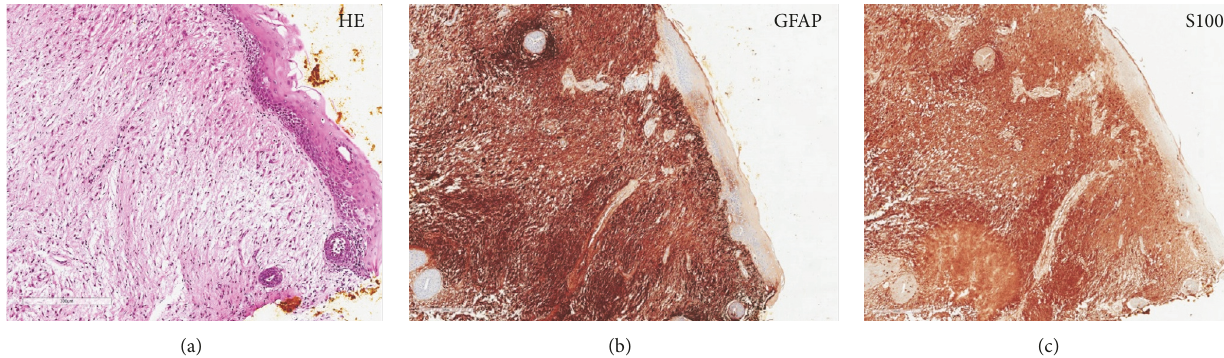
Figure 2: The histopathological findings of the mass. Hematoxylin and eosin (H&E) staining of the tissue specimen shows a subepithelial eosinophilic fibrous mass without a capsule (a). Immunostaining for GFAP (b) and S100 (c) was positive.